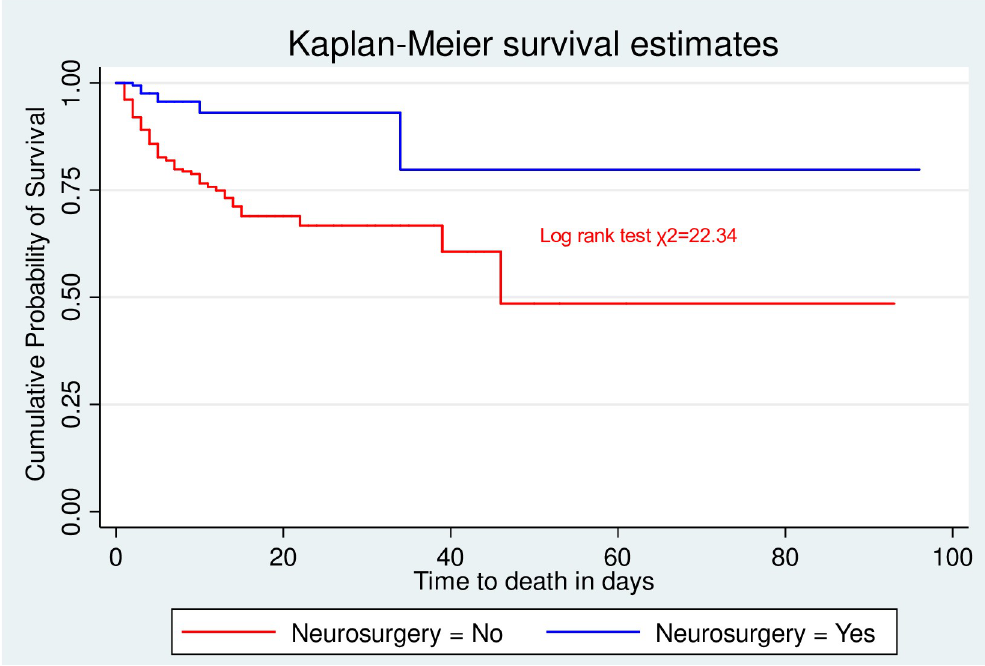
Fig 3. Kaplan-Meier survival estimate for neurosurgery among head injury admitted to HUCSH, Hawassa, Southern Ethiopia; from July 2017 to July 2019.